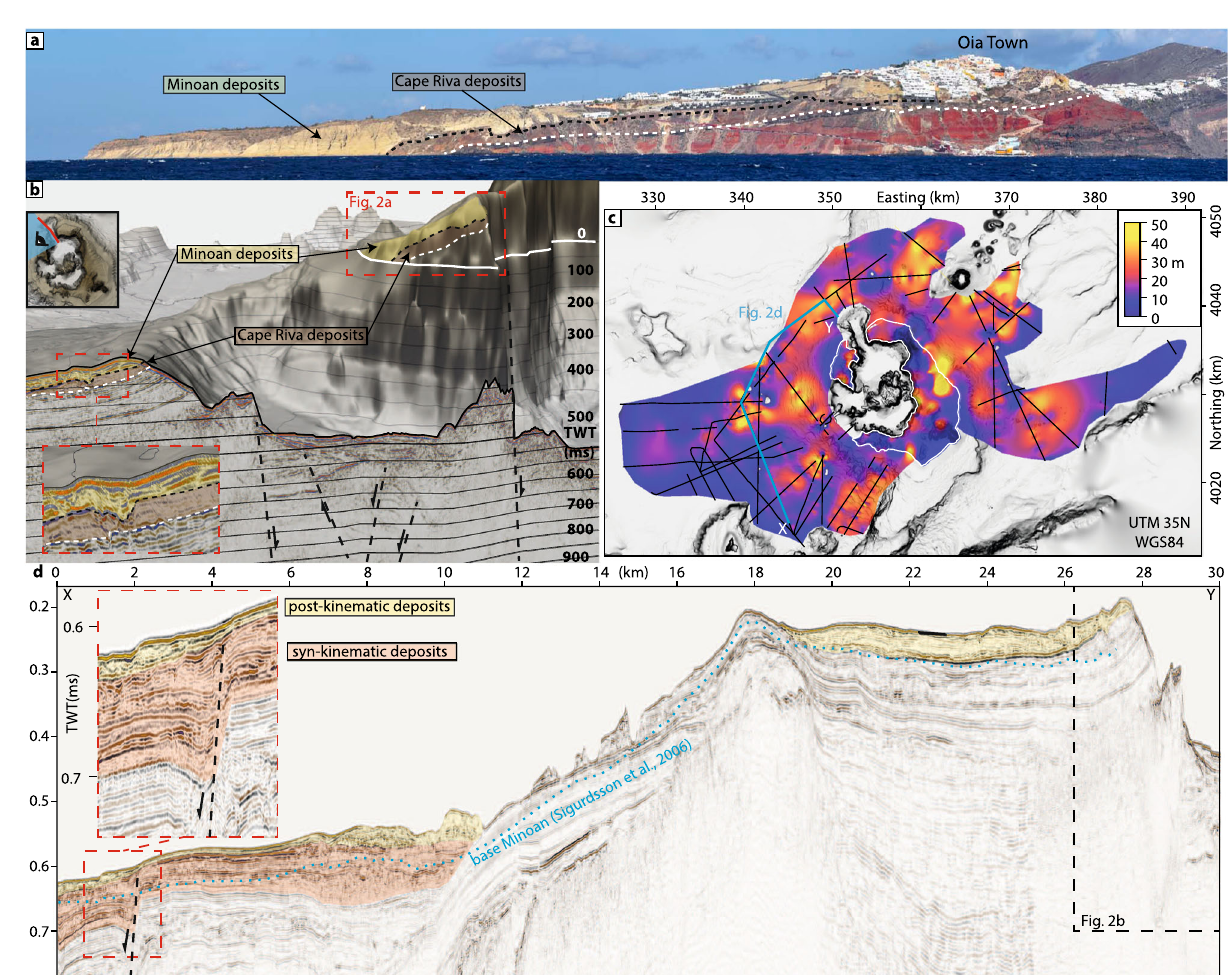
Fig. 2 | Marine ignimbrites of the Minoan eruption. a Photograph of the eastern cliff of Thera from a viewpoint on Therasia with an interpretation of the cliff stratigraphy 5,8 showing Minoan deposits atop Cape Riva eruption deposits. b Seismic pro fi le combined with a topographic grid of Santorini, including enlar- gement illustrating the stratigraphic relationship between Minoan and Cape Riva deposits. The viewpoint is also from Therasia. Interpreted seismic units and cor- responding subaerialcliffstratigraphy are coloured. c Mapshowing the ignimbrite